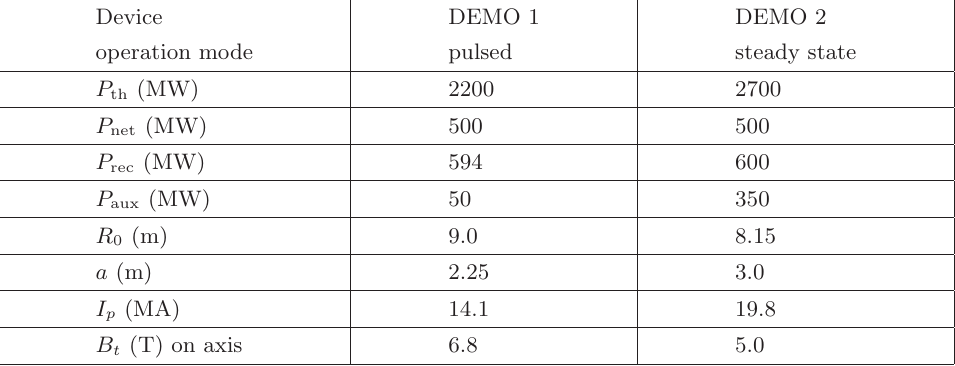
Table V. – Main parameters of the early DEMO 1 and more advanced DEMO 2 model currently under investigation by the PPP&T Department of EFDA. Shown are the thermal output power ( P th ) , the net electrical power to the grid ( P net ) , the recirculating power ( P rec ) , the auxiliary heating power ( P aux ) , major radius ( R 0 ) and minor radius ( a ) of the device, plasma current ( I p ) and toroidal magnetic field on axis ( B t )